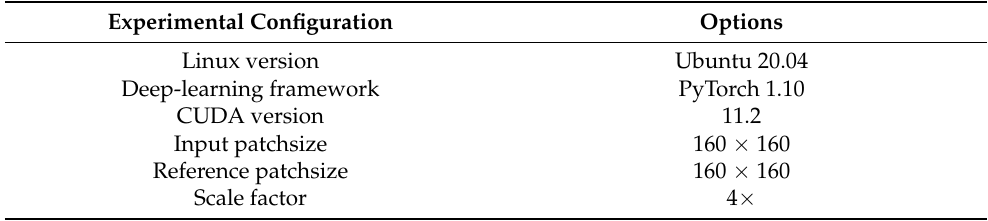
Table 1. Experimental